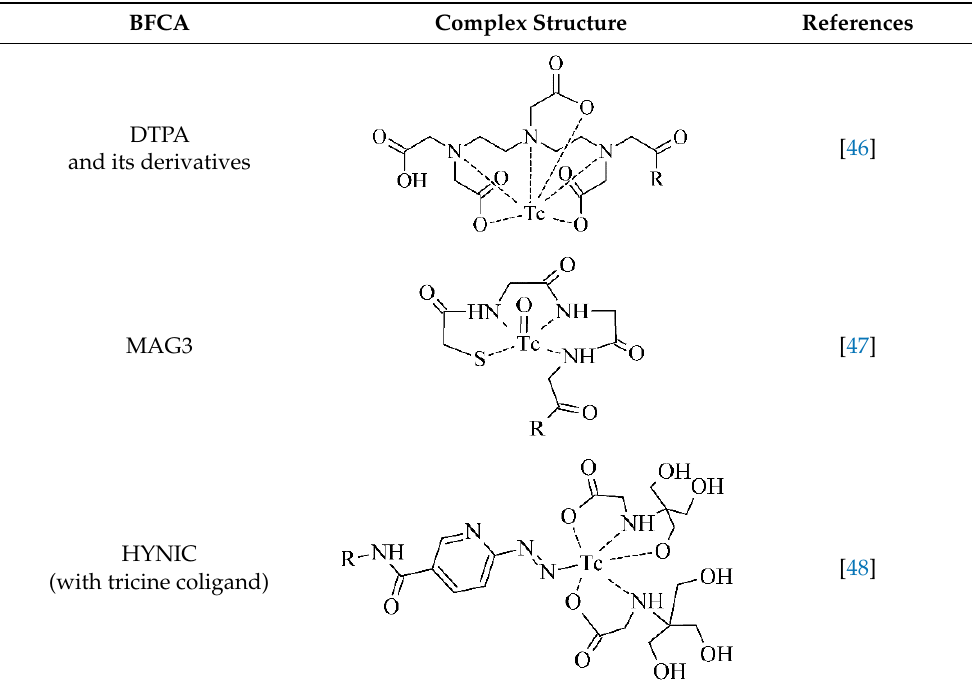
Figure 6. Scheme of the post-labeling procedure with technetium-99m (adapted according to [3]).